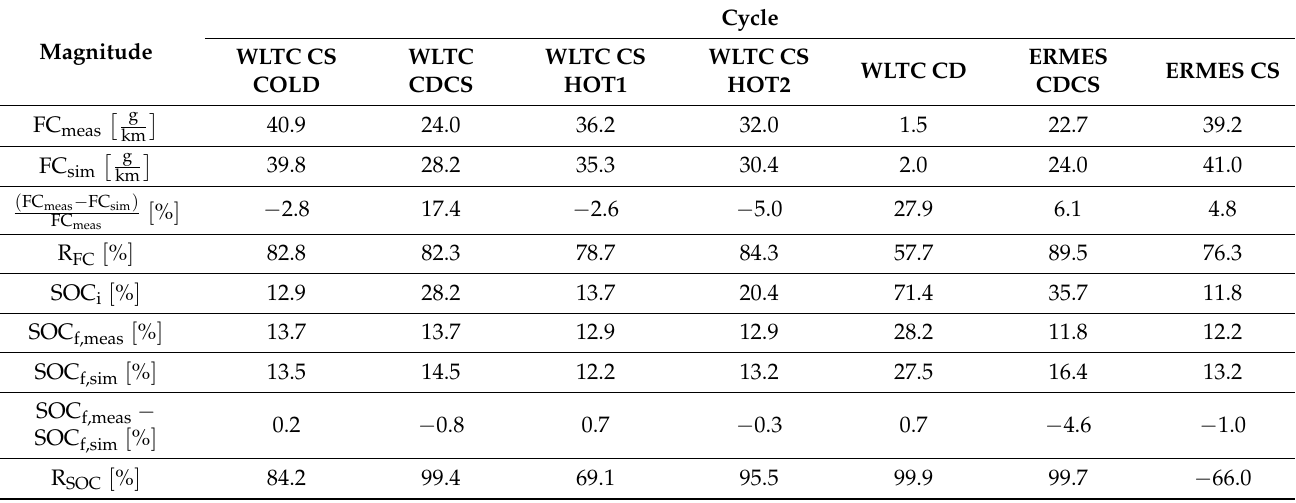
Table 5. Total FC and ∆ SOC